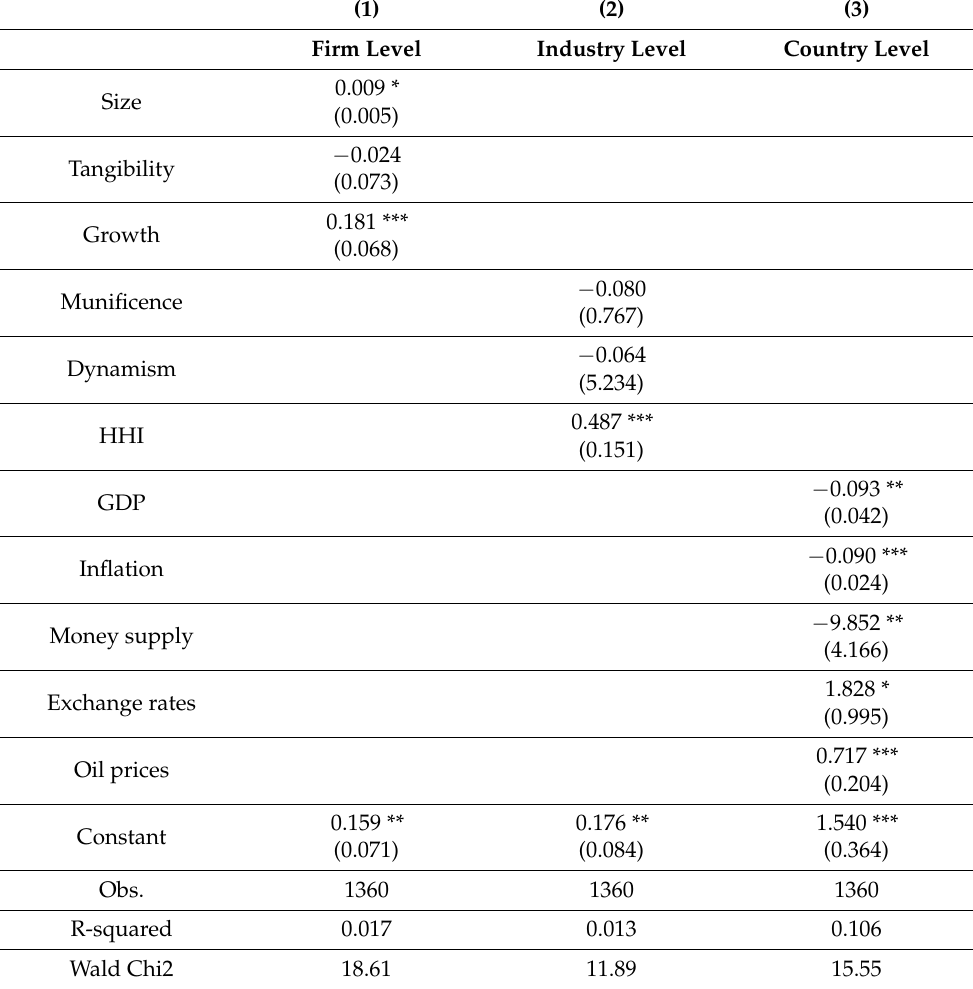
Table A4. Robustness: panel corrected standard error results.